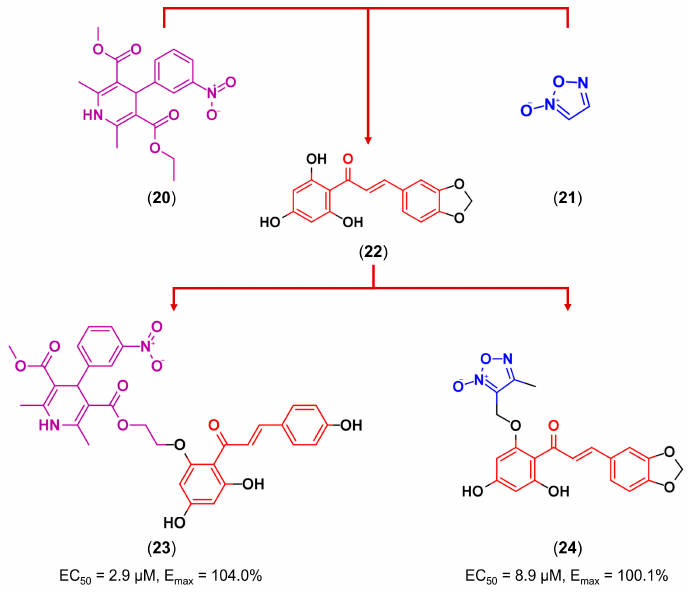
Figure 8. Molecular hybrids obtained from combination of well-known vasodilators (nitrendipine or furoxan, highlighted by purple and blue colors, respectively) and chalcones [61].